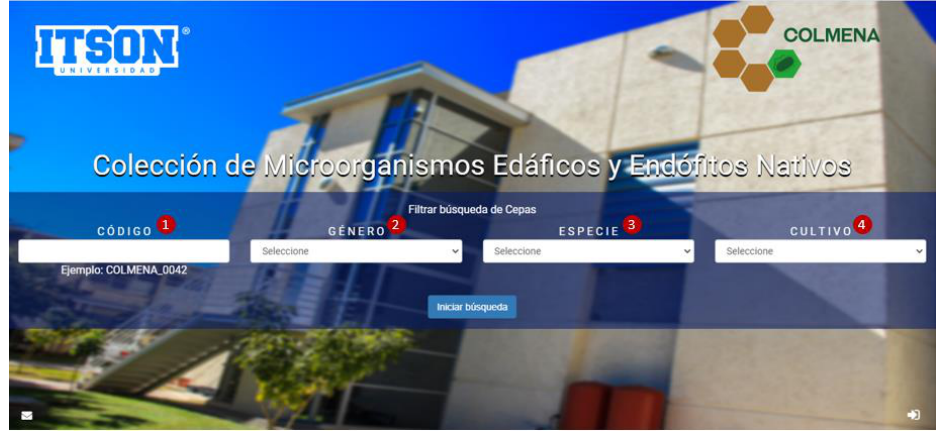
Figure 4. COLMENA’s platform categorization system (http://apps2.itson.edu.mx/colmena, accessed on 21 July